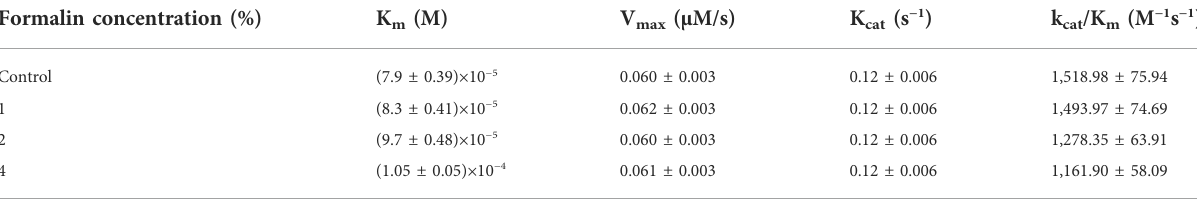
TABLE 1 Kinetics of CHT catalyzed hydrolysis of Ala-Ala-Phe-AMC at different formalin concentration. Formalin concentration